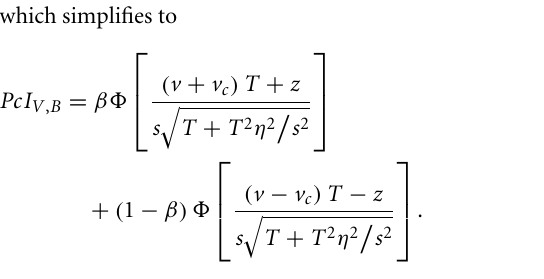
Frontiers in Psychology | Cognitive